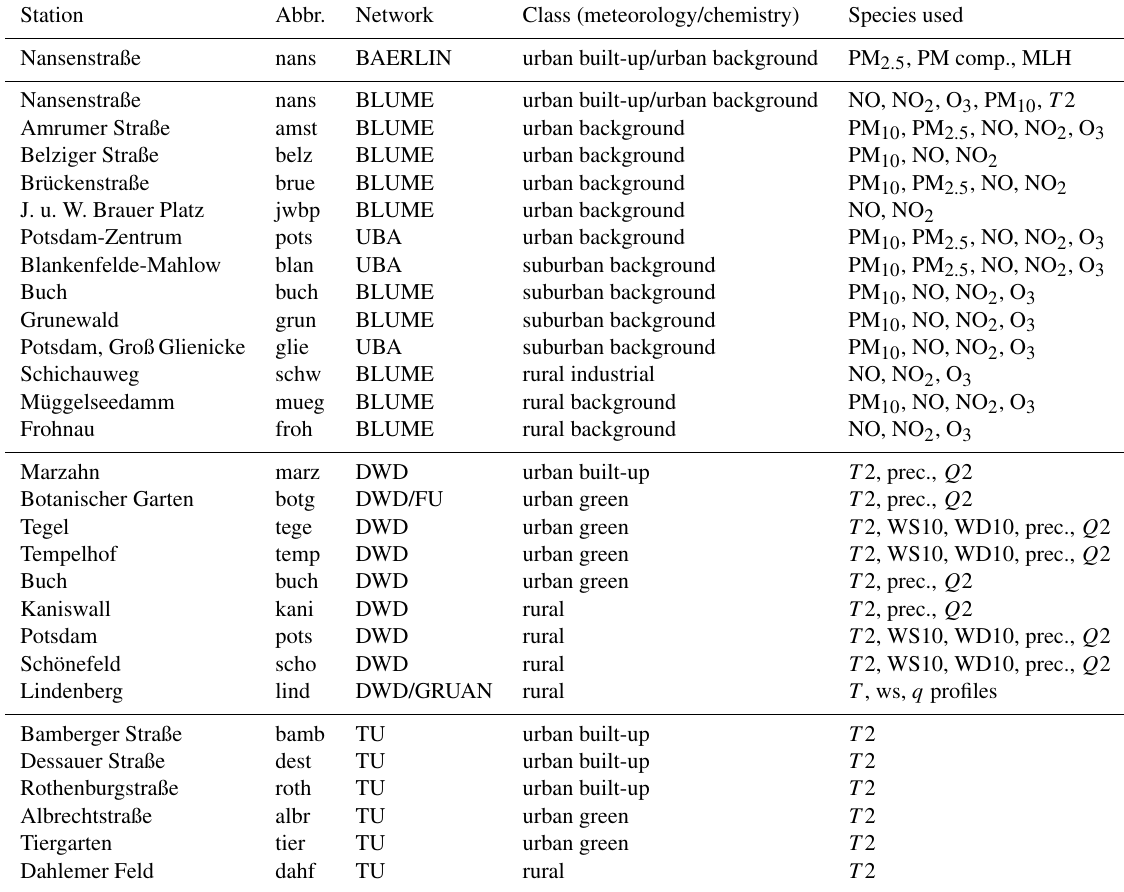
Table 3. Observational data in Berlin and Potsdam. If one class is given, it refers to the meteorology class if the network is Deutscher Wetterdienst (DWD), Global Climate Observing System Upper-Air Network (GRUAN) or TU, and to the chemistry class otherwise. The abbreviated name (Abbr.) is referred to in tables summarising statistics for the different